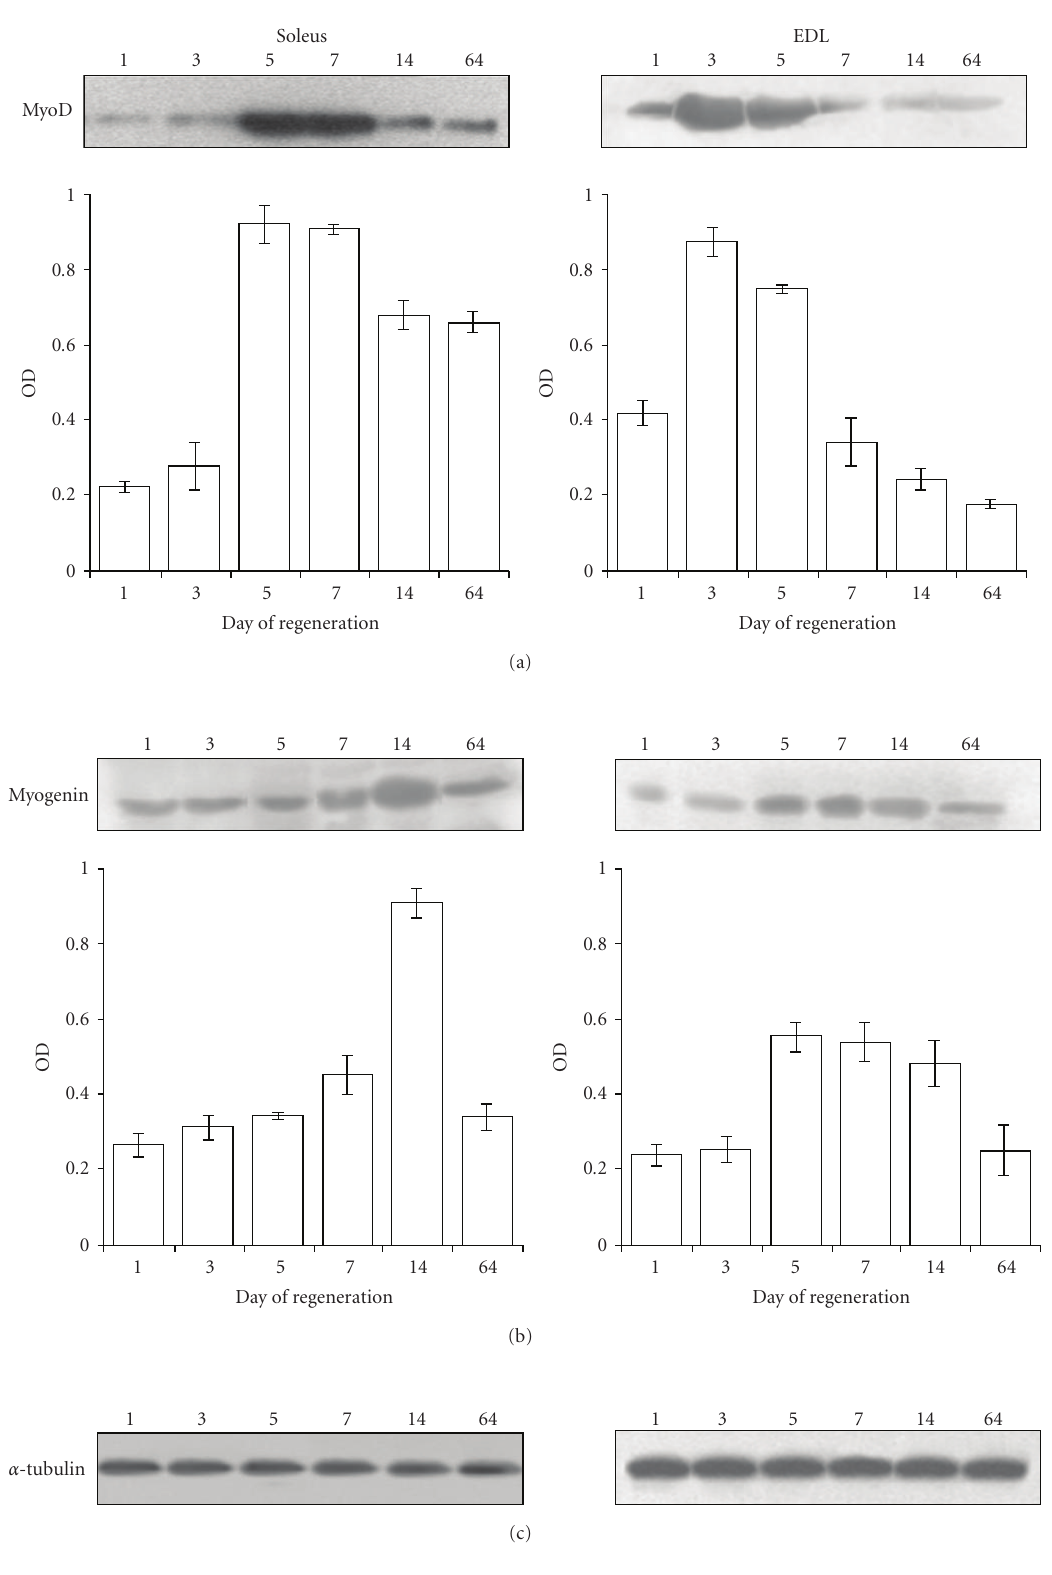
Figure 2: Pattern of MyoD and myogenin proteins in regenerating EDL and Soleus muscles . Representative immunoblots of (a) MyoD and (b) myogenin performed on extracts from regenerating soleus and EDL muscles at the indicated days after crush are shown. (c) Alphatubulin was routinely used as control of loading. Band densities of membranes from 3 di ff erent samples were scanned as described in Materials and Methods and mean values ± SE are shown as OD arbitrary